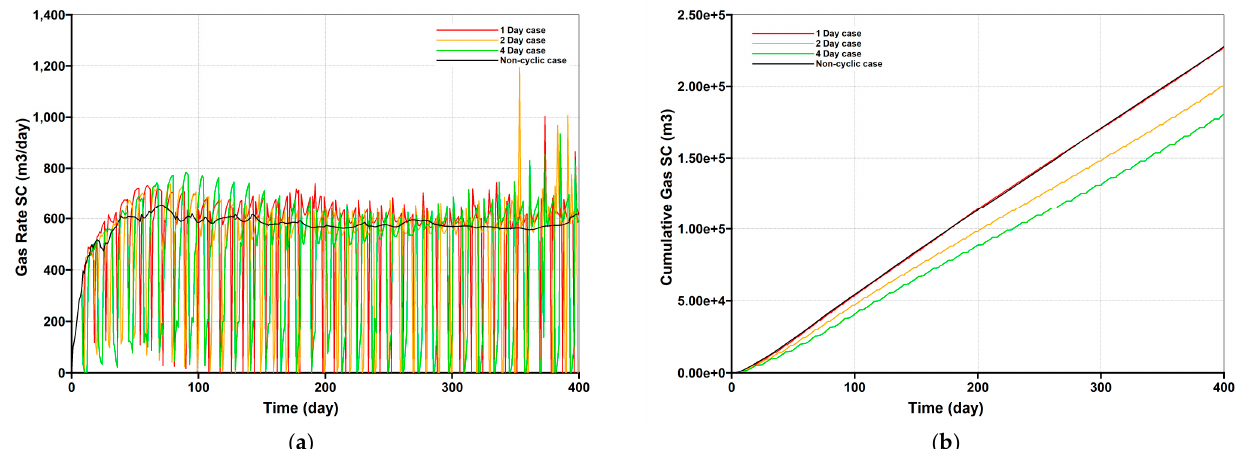
Figure 15. Results of gas production by use of different production time during secondary depressurization stage. ( a ) Gas production rate; ( b ) Cumulative gas rate.